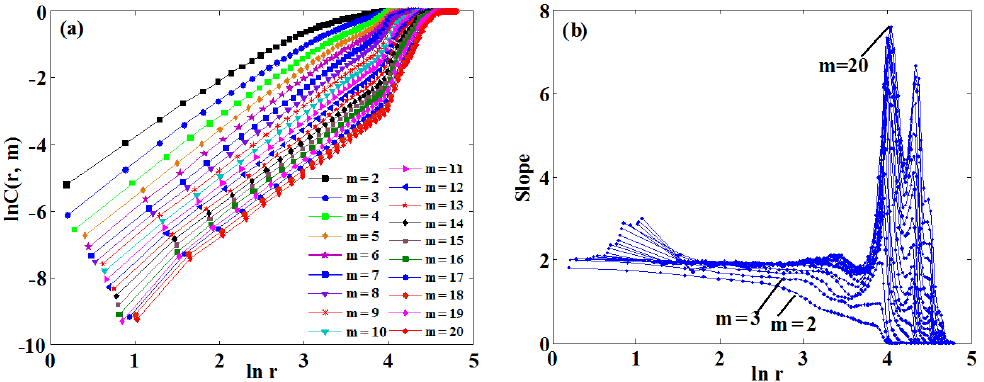
Figure 3. Correlation integral as a function of r , with embedding dimension m ranging from 2 to 20 for the Lorenz attractor: (a) ln C ( r , m ) vs. ln r , (b) the slopes of ln C ( r , m ) vs. ln r.